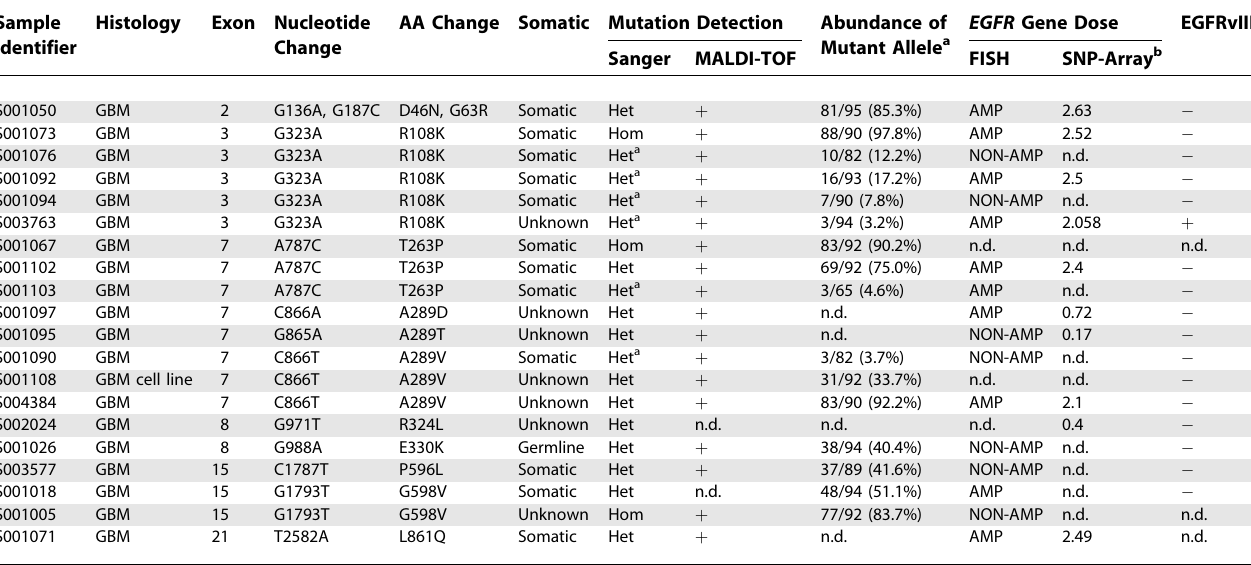
Tabulated are sample identification numbers, source of the DNA (primary tumor versus cell line), site of the mutation (exon number, nucleotide change, amino acid change), homozygous versus heterozygous occurrence of the mutation, genotype of corresponding germline DNA, mutation detection method (Sanger sequencing, MS genotyping), abundance of the mutant EGFR allele (see Methods section), EGFR gene dosage, and EGFRvIII status. The sample set included 132 glioblastomas, 11 WHO grade III gliomas, and eight glioblastoma cell lines. a Number of colonies with mutant/number of colonies with wild-type EGFR . b Smoothened log 2 ratio at the EGFR locus. AA, amino acid; AMP, amplified; GBM, glioblastoma; Het, heterozygous; Hom, homozygous; n.d., not determined (failed reaction or sample not available); NON-AMP, not